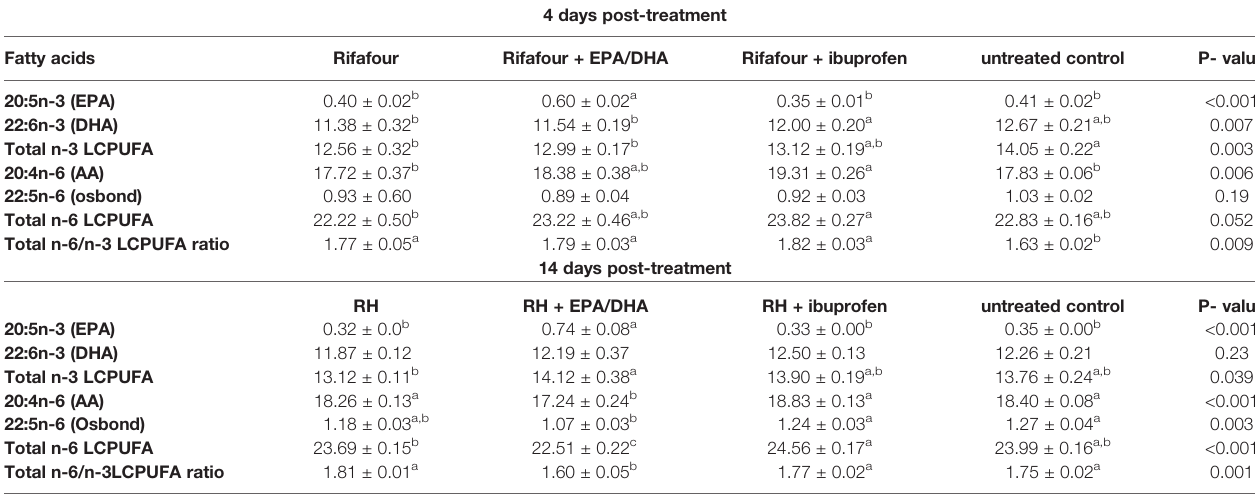
TABLE 1 | Phospholipid fatty acid composition of PBMC in Mtb- infected C3HeB/FeJ mice receiving EPA/DHA or ibuprofen adjunct treatment at different time points #